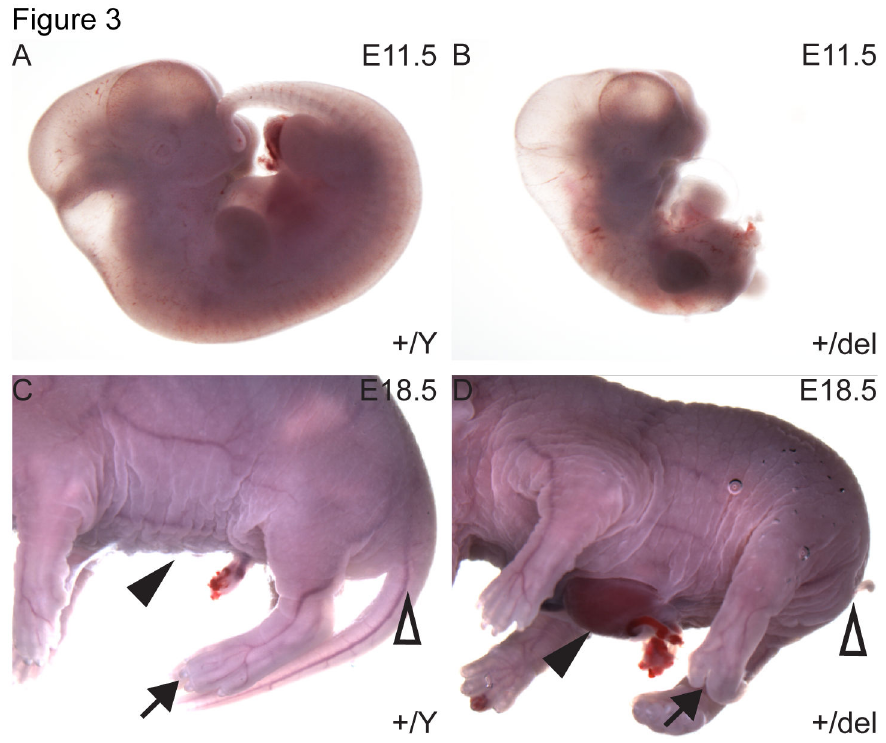
Figure 3. Gross morphological abnormalities in Porcn +/del fetuses. At E11.5, heterozygous females with posterior truncations could be observed (B), while wildtype Porcn +/Y littermates (A) developed normally. Just prior to birth (E18.5), several Porcn +/del females (D) displayed defects in body wall closure (arrowhead), digital abnormalities (arrow) and lack of tail (open arrowhead). Male littermates never displayed these defects